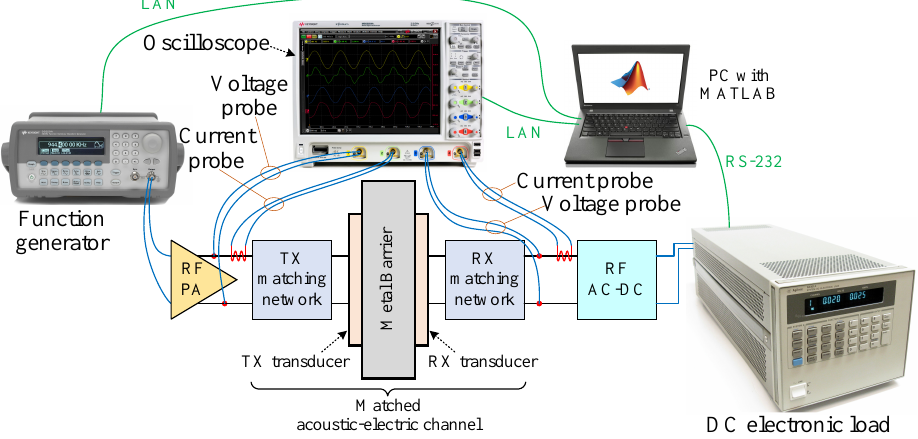
Figure 12. System measurement